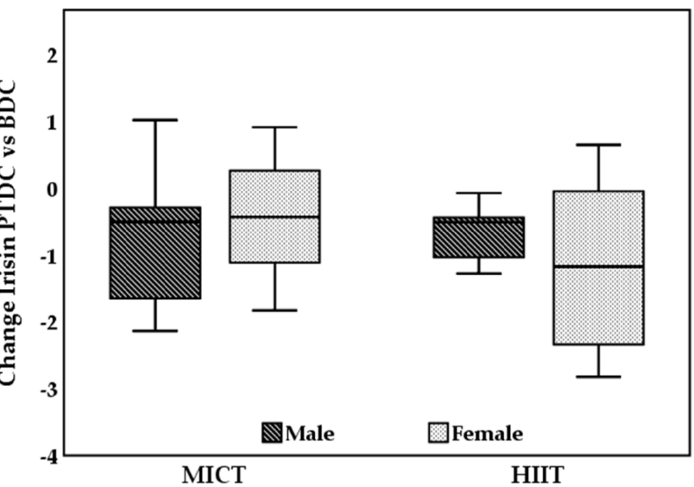
Figure 3. Sex-specific changes in circulating level of irisin after the aerobic training of 12 weeks with MICT group or HIIT. BDC, baseline data collection; PTDC, post training data collection; MICT, moderate-intensity continuous training; HIIT, high-intensity interval training.